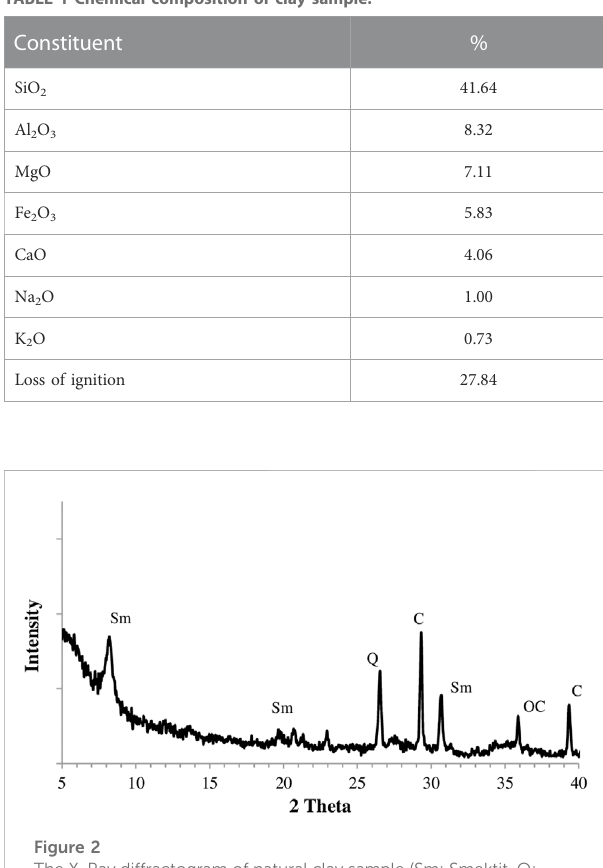
TABLE 1 Chemical composition of clay sample.